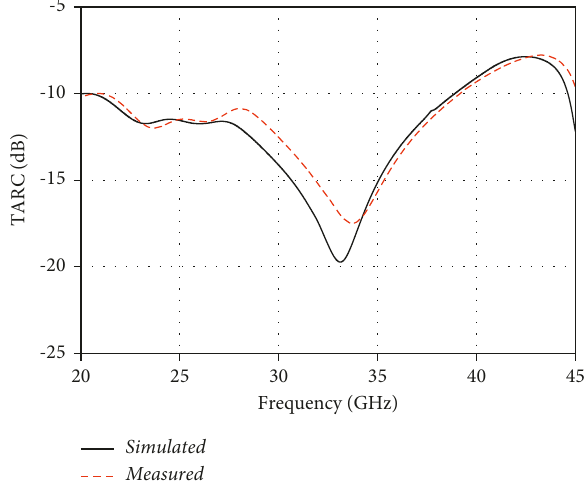
Figure 19: Simulated and measured TARC vs. frequency.